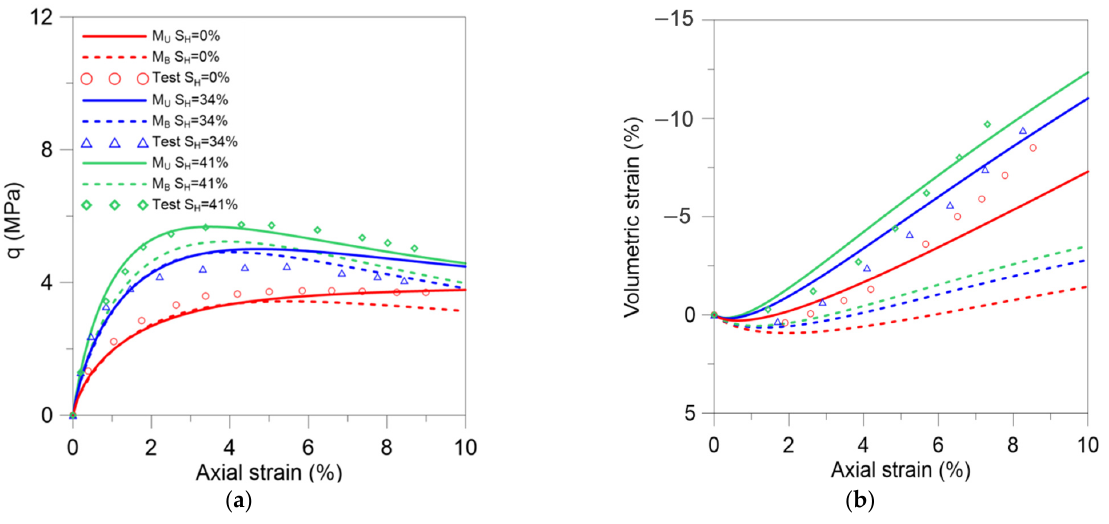
Figure 5. Modeling the tests reported in Miyazaki et al. [82] at 𝜎 3 = 1 MPa. ( a ) Deviatoric stress versus axial strains; ( b ) volumetric strains versus axial strains.